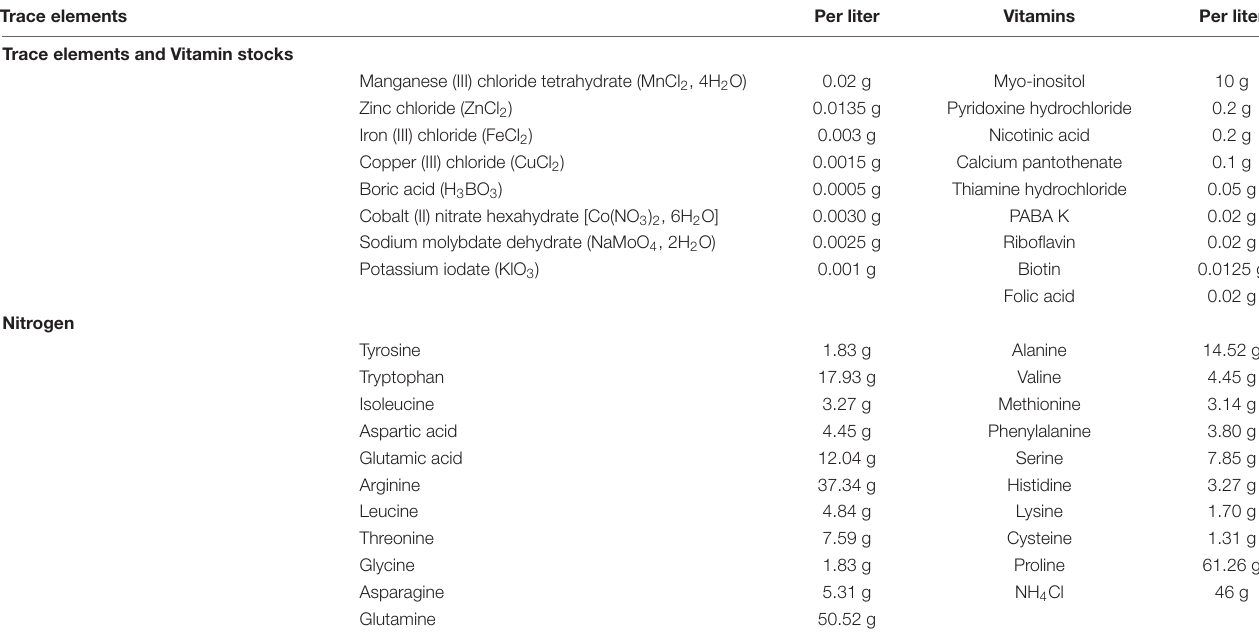
TABLE 1 | Trace elements, vitamins and nitrogen stock (with amino acids and ammonium chloride) used to prepare grape juice-like synthetic medium. Trace elements Trace elements and Vitamin